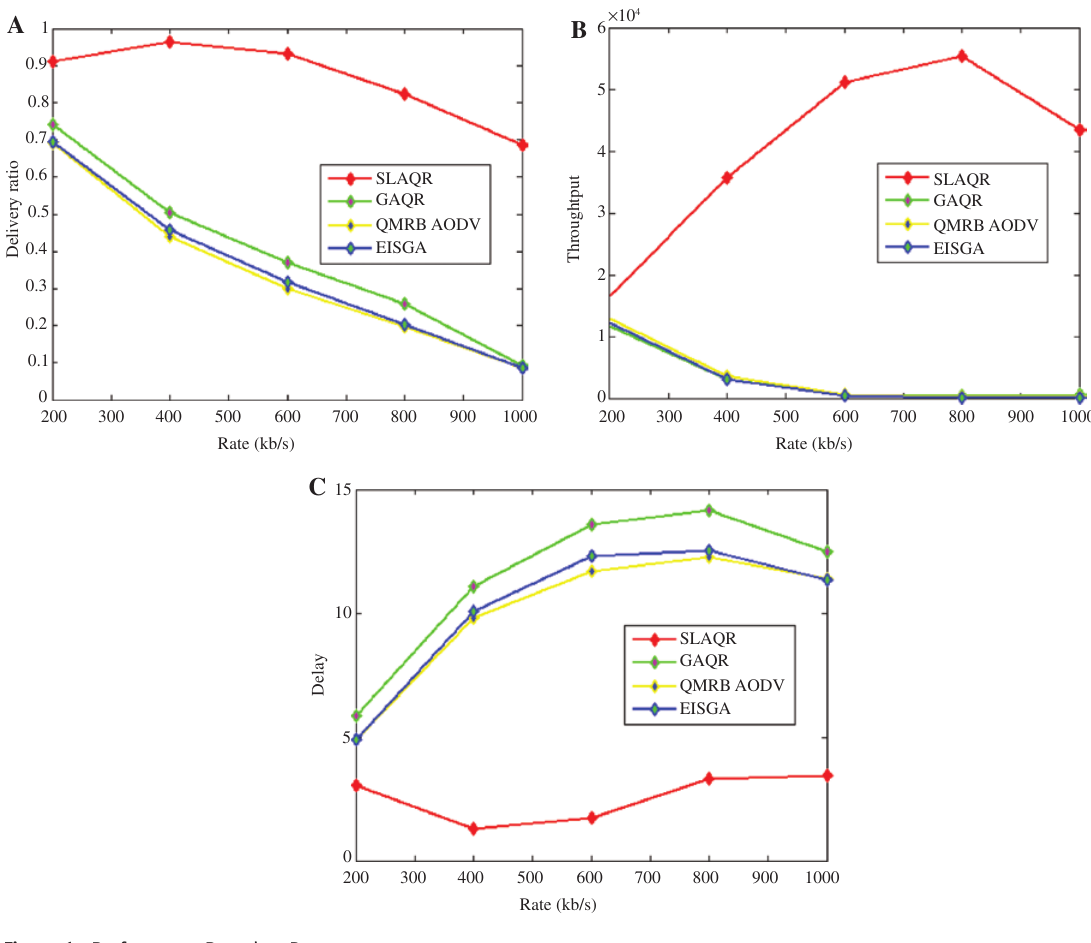
Figure 6: Performance Based on Rate. (A) Delivery ratio. (B) Throughput. (C)